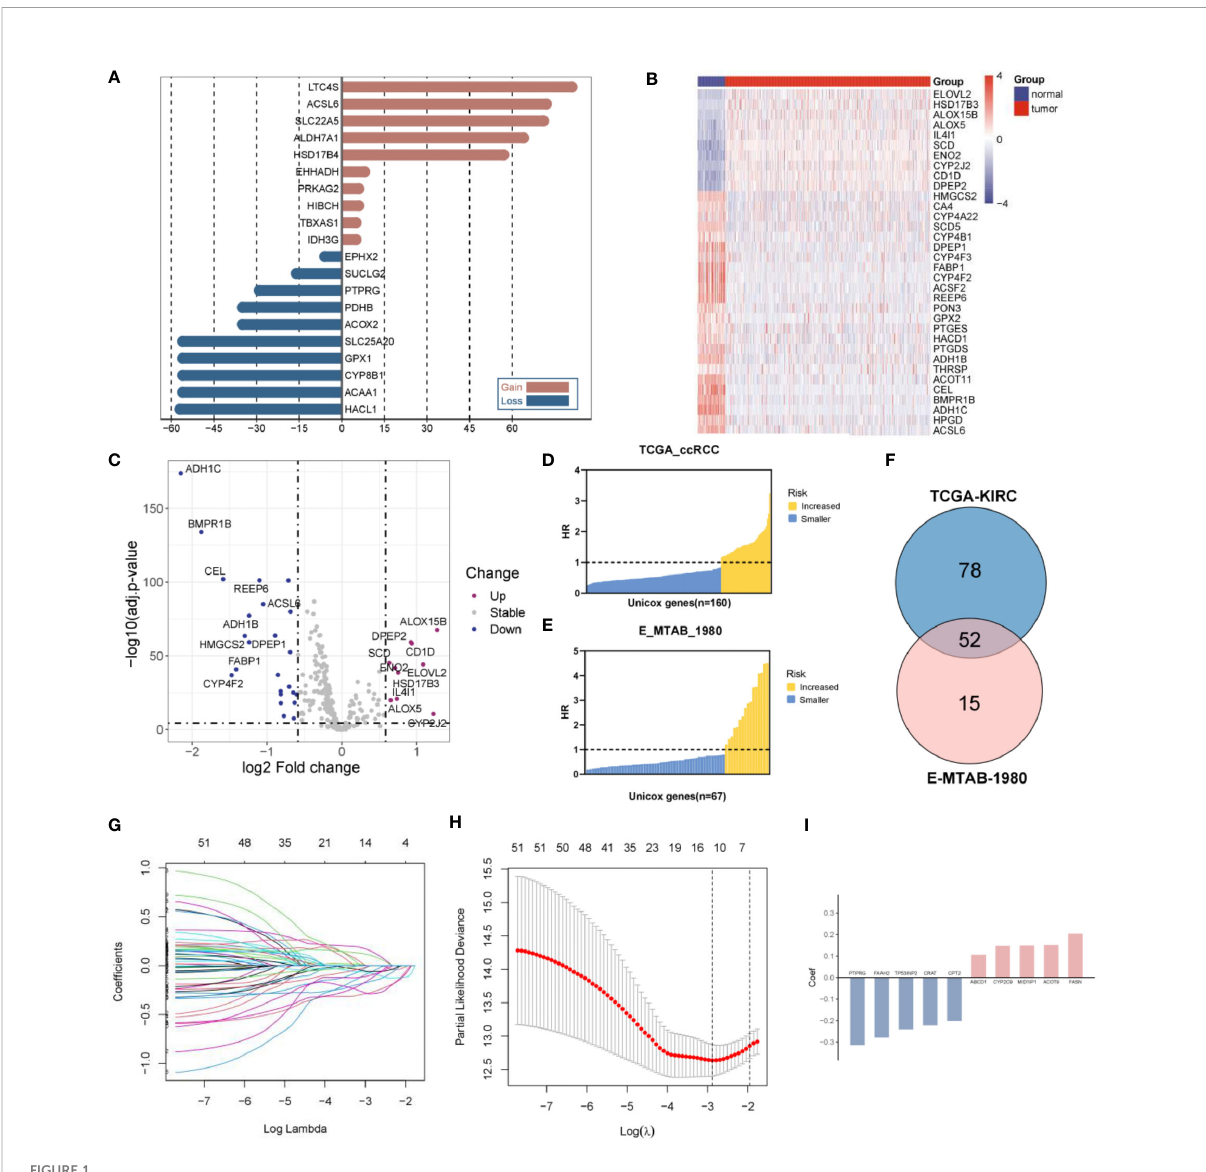
FIGURE 1 Construction of a fatty acid metabolism-related signature in ccRCC patients. (A) The frequency of the top 10 genes with ampli fi ed or deleted CNVs of FMGs in the TCGA-KIRC cohort. (B) Heatmap analysis of 34 DEGs among FMGs. (C) Volcano plot depicting the distribution of DEGs. (D) 160 prognostic FMGs in the TCGA-KIRC dataset. (E) 67 prognostic FMGs in the MTAB dataset. (F) Venn plot identifying 52 overlapping prognostic FMGs. (G) LASSO Cox regression analysis of the 52 prognostic FMGs. (H) Plot depicting partial likelihood deviance of the LASSO regression. (I) Corresponding coef fi cients of the 10